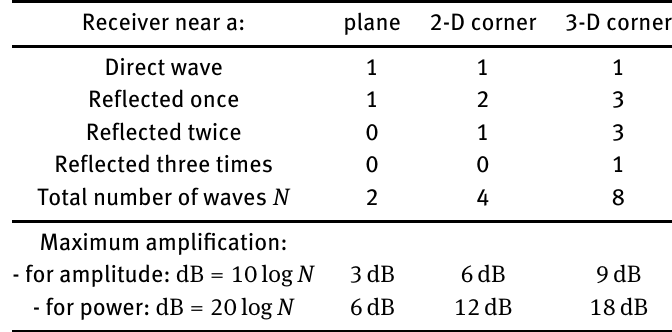
Table 3: Maximum amplification from wall reflections.